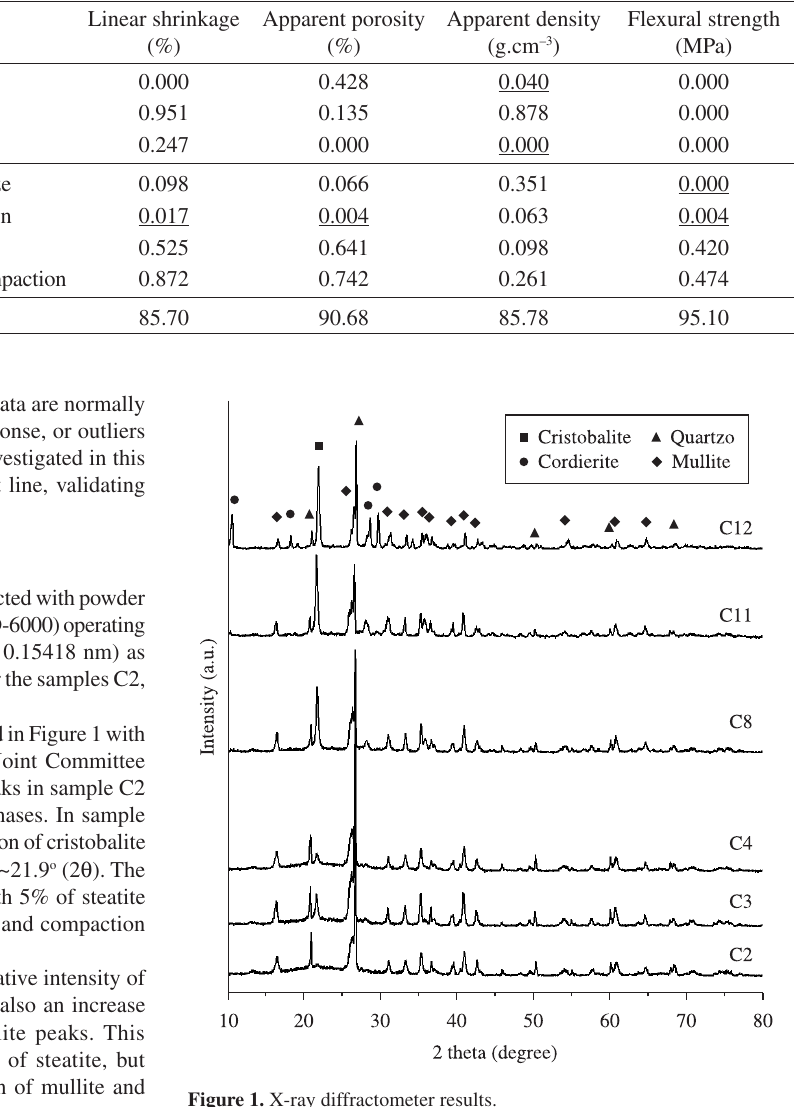
Table 4. Analysis of variance (P-values).